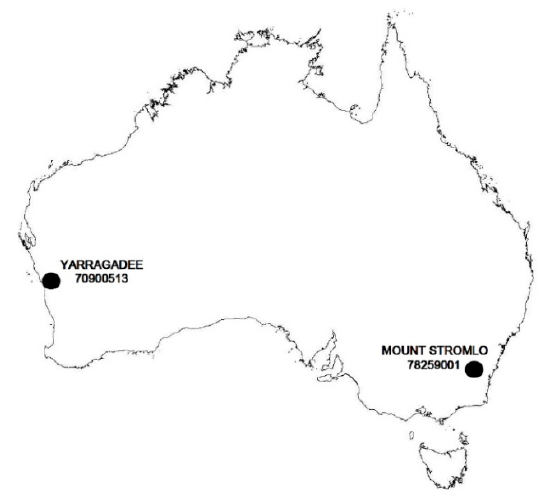
Figure 1. Location of the Australian satellite laser ranging (SLR) stations.